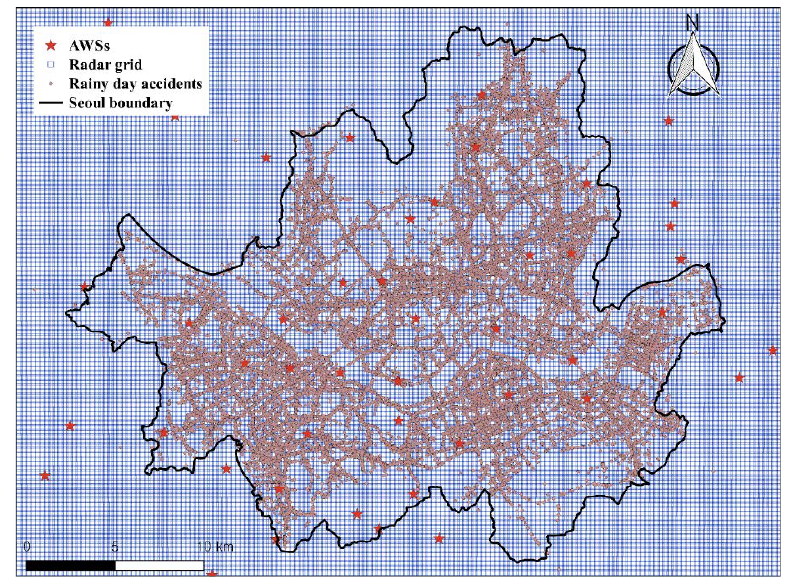
Figure 1. Locations of selected traffic accidents on rainy days, April to October 2008–2017; automatic weather stations (AWSs); and weather radar grid in Seoul.